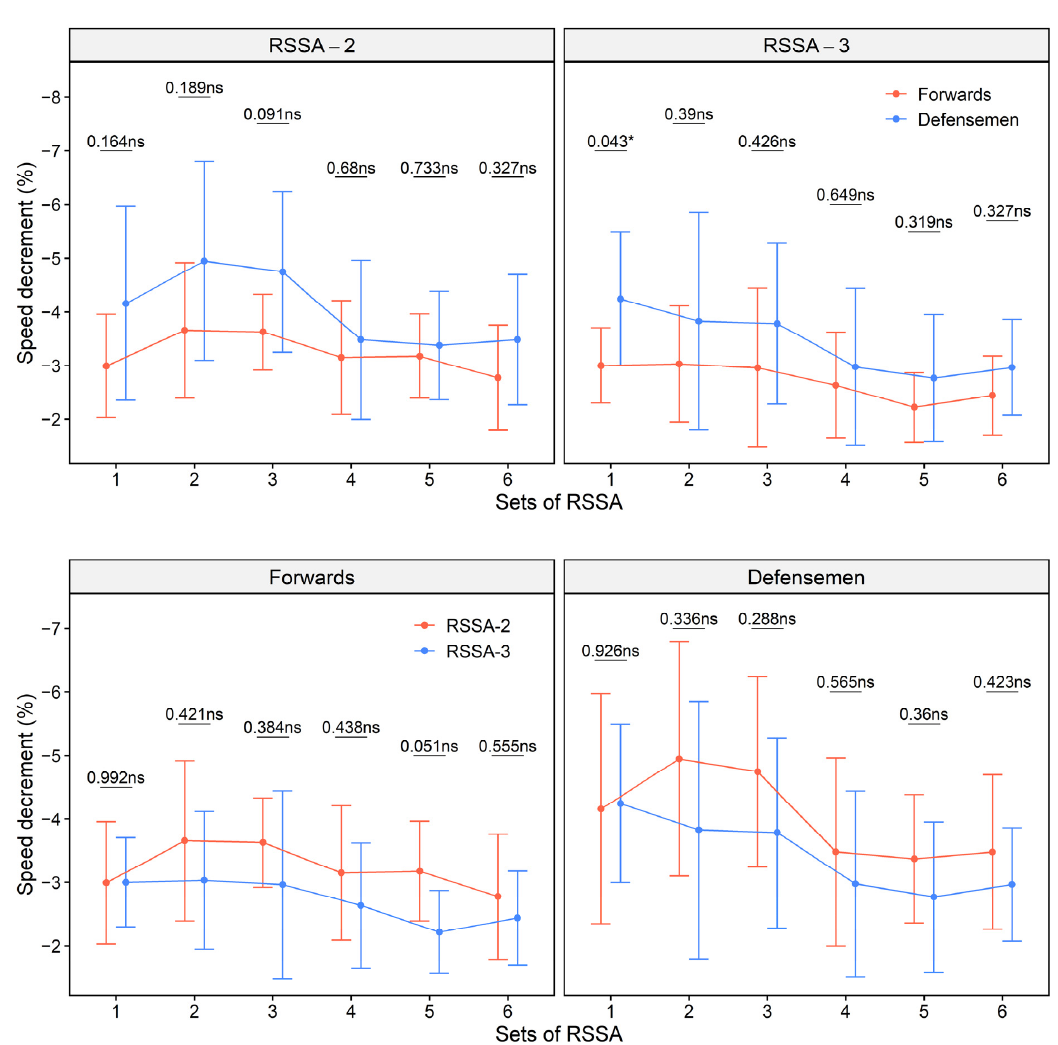
Figure 3. Speed decrement of the forwards and defensemen in RSSA-2 and RSSA-3 tests (ns—non-significant; * p < 0.05).